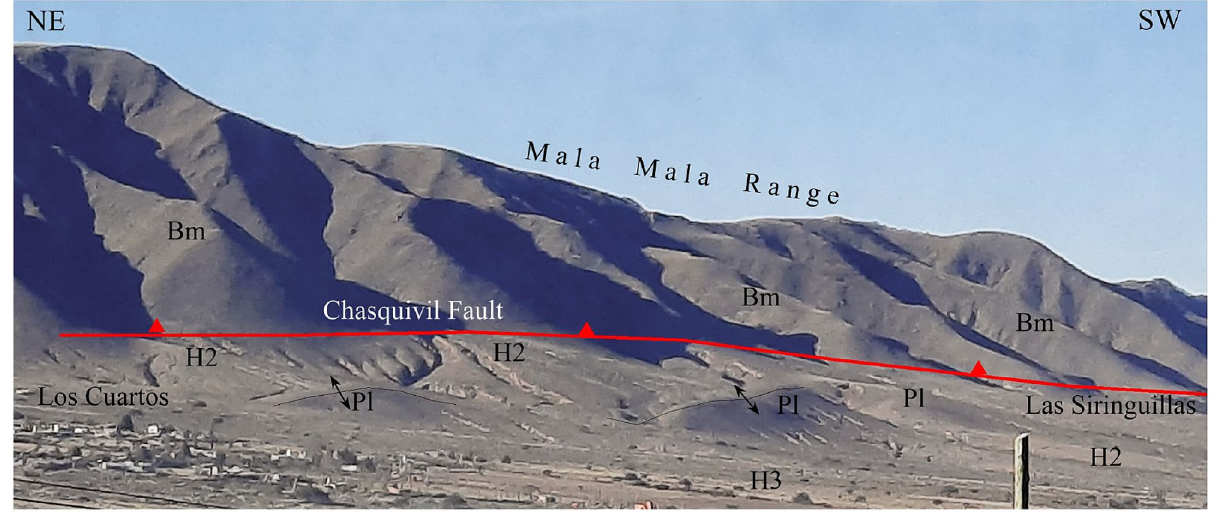
Fig. 12 Photo showing the deformation of the piedmont by neo‑ tectonic processes associated with the Chasquivil fault. Hills ori‑ ented to the NNW are observed, made up of Pleistocene sediments,